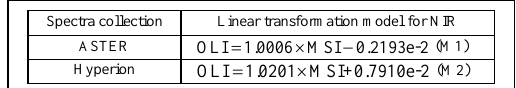
Table 4. Linear transformation model for NIR channel (785– 900 nm) using the median coefficients in Figure 5 and Figure 6.